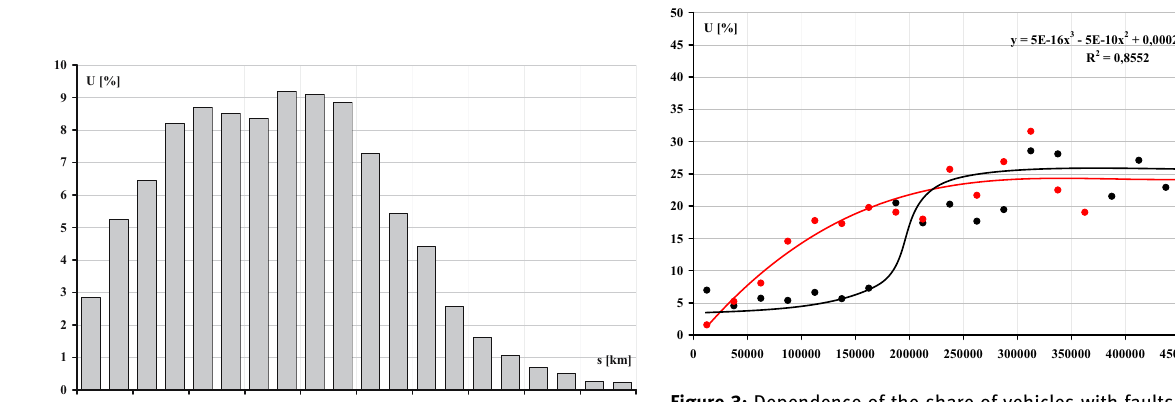
Figure 3: Dependence of the share of vehicles with faults on the mileage of vehicles powered by petrol ( red line ) and diesel ( black line )